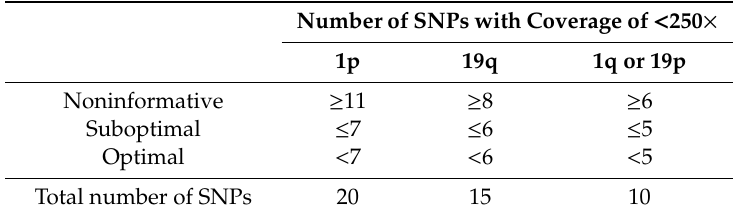
Table 3. Quality criteria applied to the single nucleotide polymorphism (SNP)